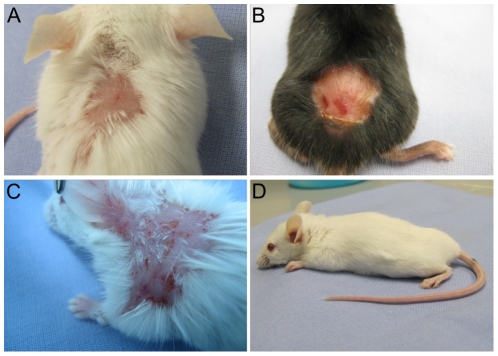
Subcutaneous injection of BP180/CXVII-specific IgG induces blister formation in adult mice.Skin lesions, including blisters, erosions crusts, and alopecia developed in (A) BALB/c, (B) C57BL6, and (C) SJL-1 mice pre-sensitized with rabbit IgG and subsequently receiving, over a period of 10 days, 6 s.c. injections of IgG, each containing 15 mg of IgG, from a rabbit immunized against murine BP180/CXVII. (D) A control mouse pre-sensitized with rabbit IgG and challenged with the same dose of normal rabbit IgG showed no skin alterations.